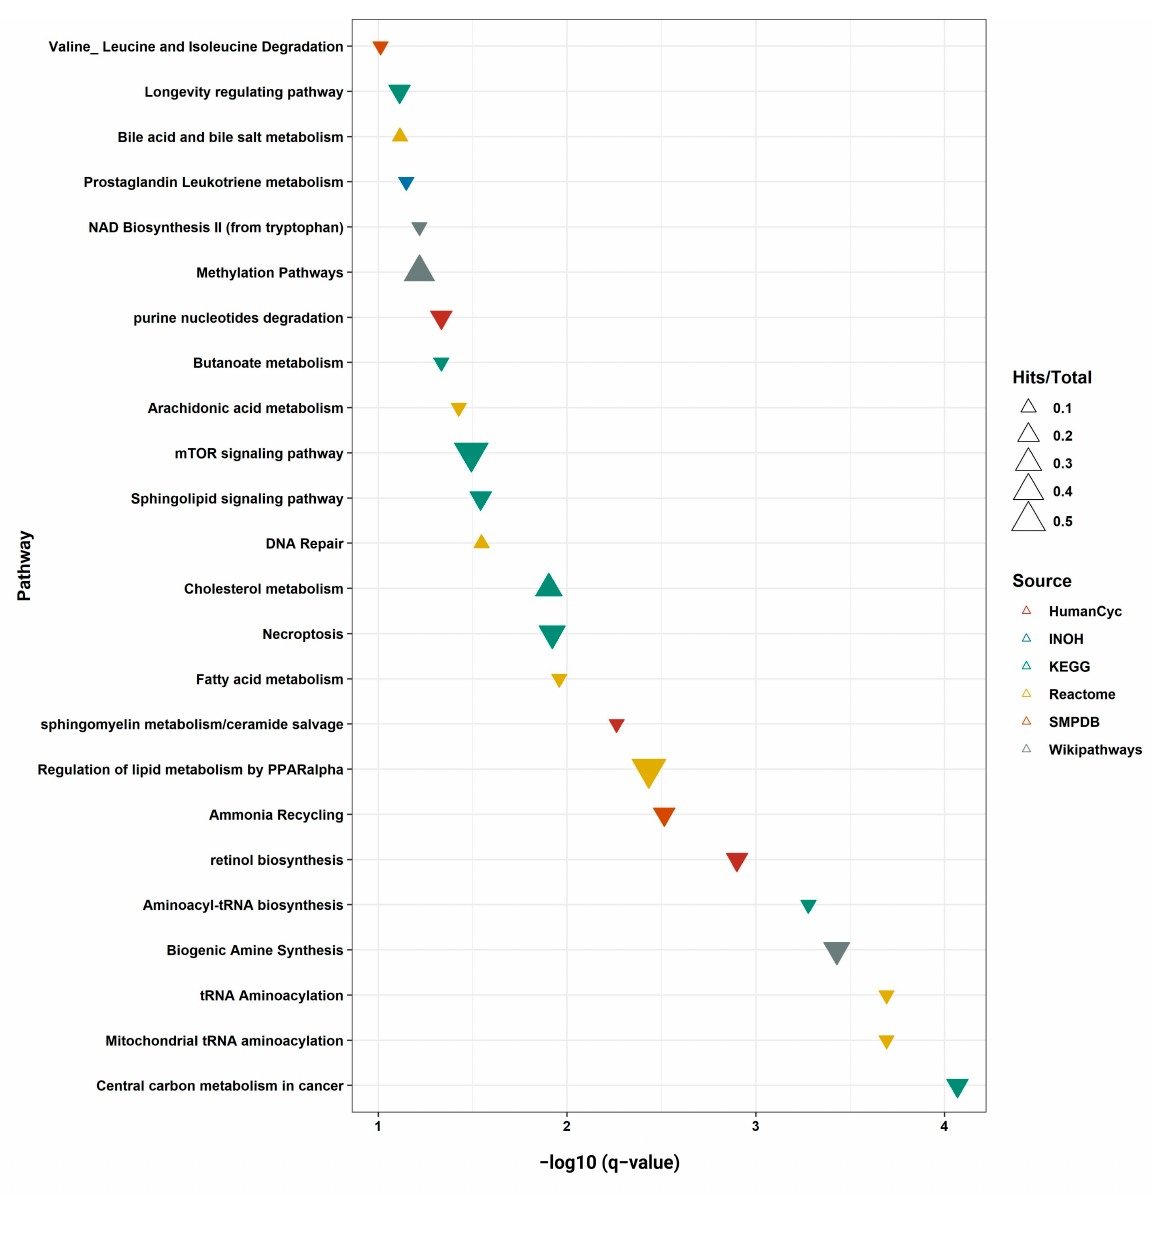
Figure 7. ( A ) Pathway enrichment analysis with FDR 10% (q-value) and p -value < 0.05 using different sources as background database search. Each database is illustrated with a color code in the figure legend. The size of the circle reflects the number of metabolites found in this pathway over the total metabolites. The x-axis is the − log10 of the q-value. This analysis includes both up- and down-regulated metabolites with a fold change cut-off equal to 1.5. ( B ) Pathway enrichment analysis with FDR 10% (q-value) and p -value < 0.05 using different sources as background database search. Each database is illustrated with a color code in the figure legend. The size of the arrows’ head reflects the number of metabolites found in this pathway over the total metabolites. The x-axis is the − log10 of the q-value. This analysis includes up- or down-regulated metabolites with a fold change cut-off equal to 1.5, as described in the Materials and Methods. If the head of the arrow point is upward, that pathway is only enriched using the upregulated metabolites. If the head of the arrow is downwards, that pathway is only enriched using the down-regulated